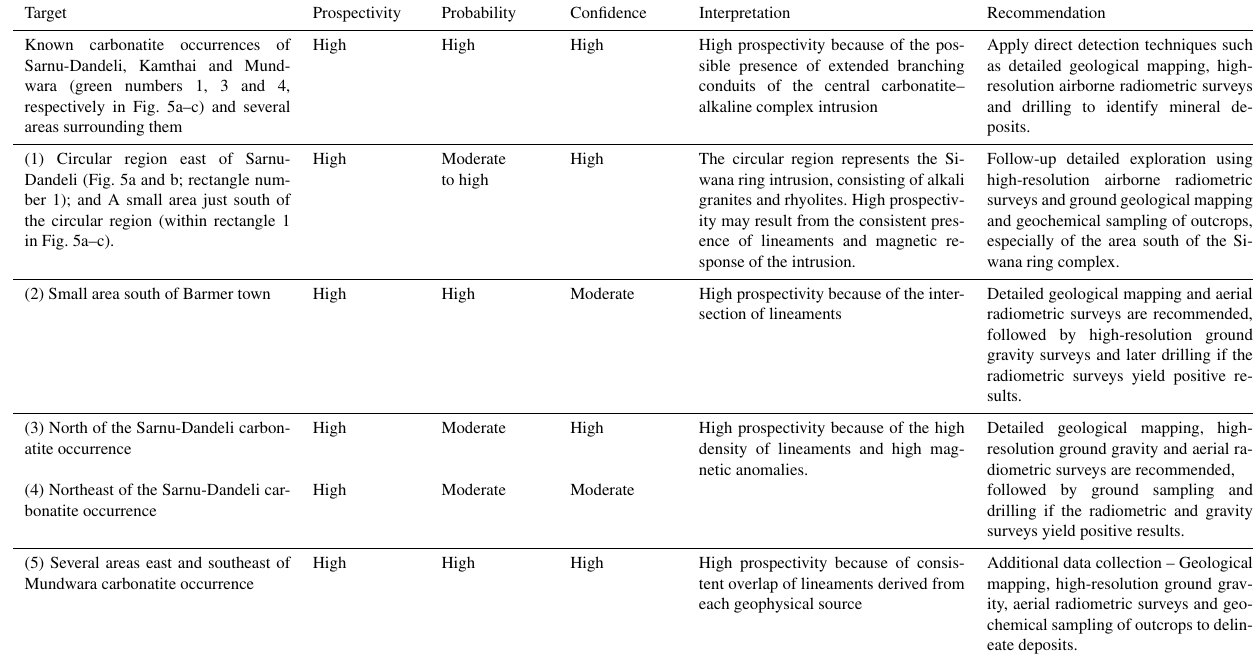
Table 6. Matrix summarising the target areas quantified according to probability and confidence levels, and recommended exploration. Target serial numbers refer to the rectangle numbers in Fig.